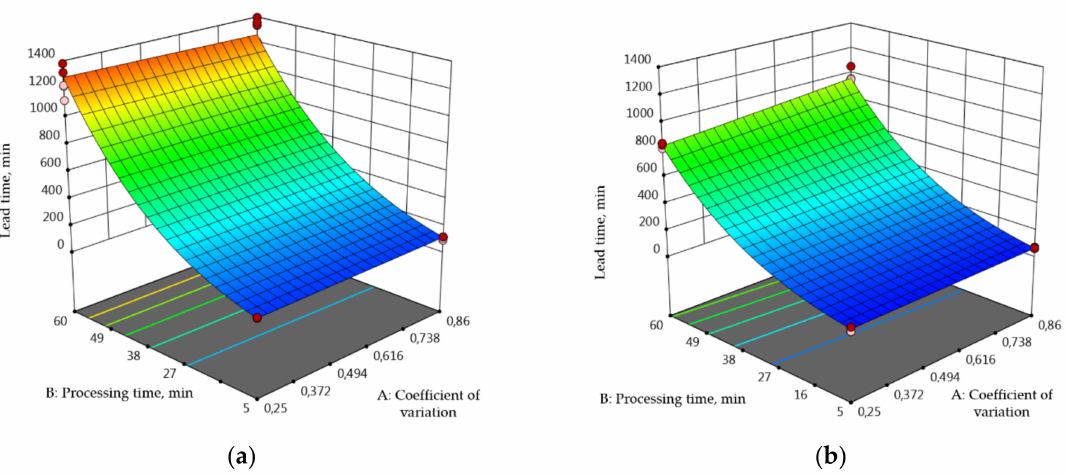
Figure 6. Response surface 3D plots: ( a ) Effects of coefficient of variation and operation time on lead time for the process with bottleneck and three Conwip cards in each operation (15 cards for the whole process); ( b ) Effects of coefficient of variation and operation time on lead time for the process with bottleneck and two Conwip cards in each operation (10 cards for the whole process.